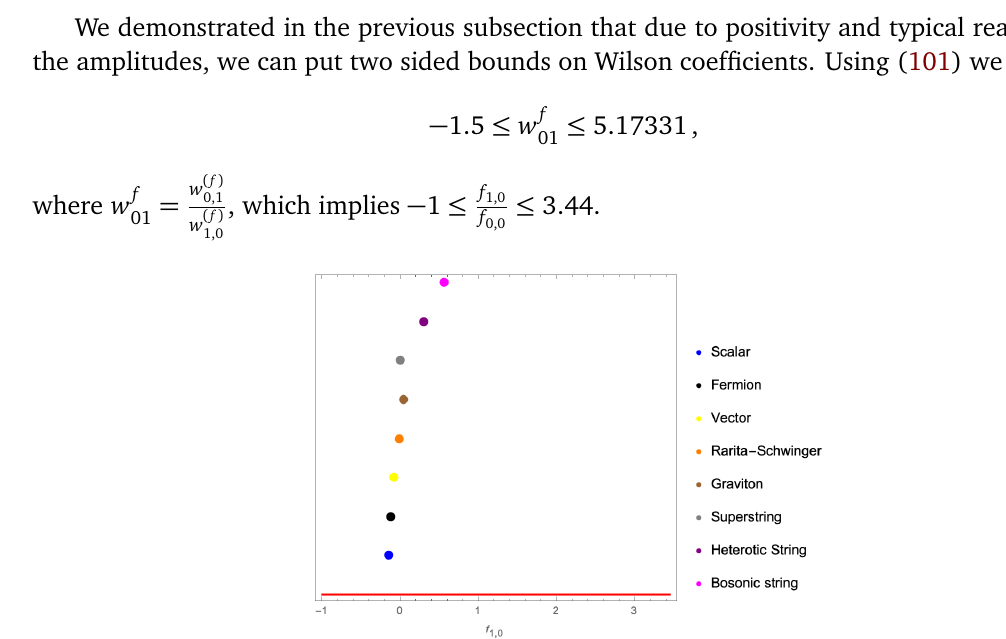
Figure 6: A line plot to show the allowed range of f photon, gravitino, graviton, super string, Heterotic string and bosonic string sector benchmarked.